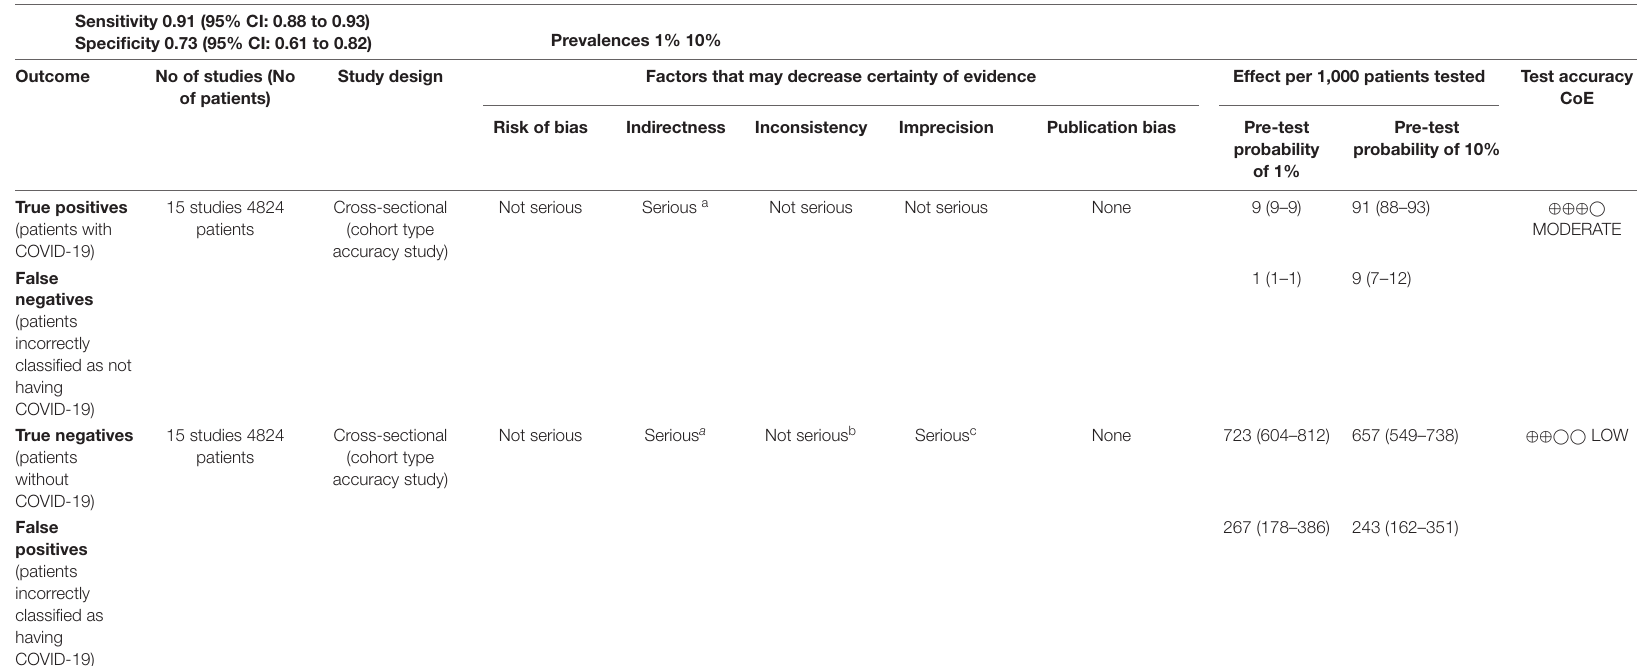
TABLE 4 | Summary of findings. Question: Should Chest CT be used to screen for COVID-19 in patients that require emergency surgery due to